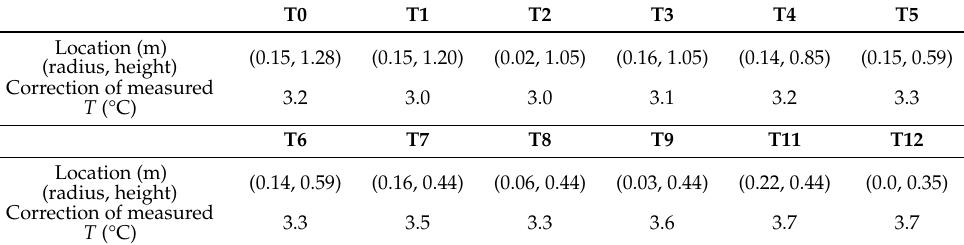
Figure 2. Temperatures observed at the installed RTDs (cf. Table 2 for their coordinates) during the hydrate formation experiment in LARS (left) with their relative location (right, not to scale). Observa- tions at T0–T12 are modified from a hydrate formation experiment conducted by Priegnitz et al. [27]. Table 2. Spatial locations of RTDs employed in LARS with the temperature deviation considered for their